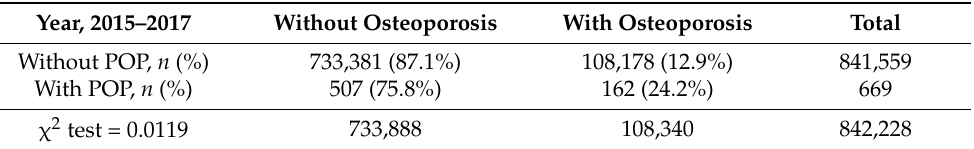
1926 395 2321 Table 5. Pelvic organ prolapse (POP) and osteoporosis prevalence in women aged over 50 years in 2015–2017 (1:10 age-stratified matching